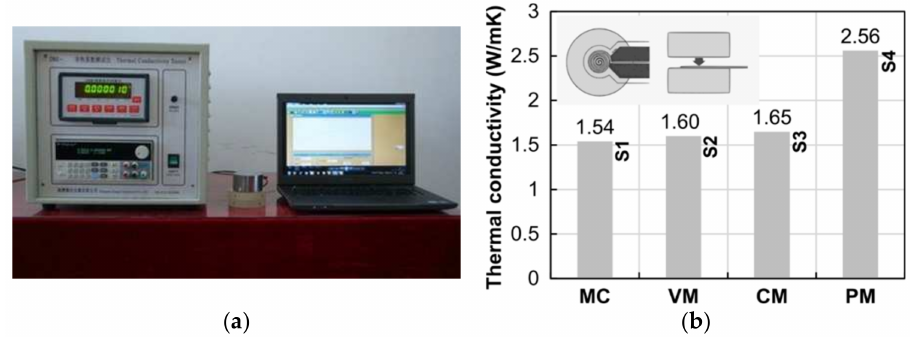
Figure 7. Thermal conductivity test. ( a ) DRE thermal conductivity parameter test machine. ( b ) Test